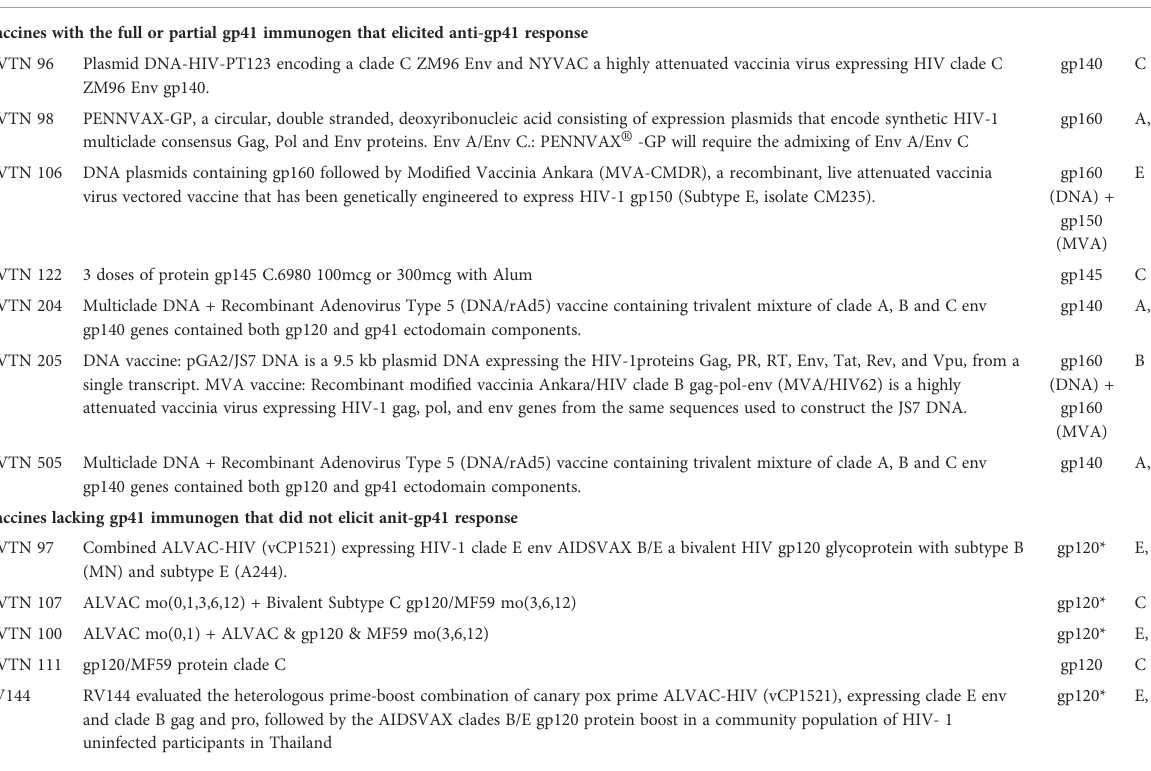
TABLE 2 Vaccine product description by trial. Trial Vaccine Product Env